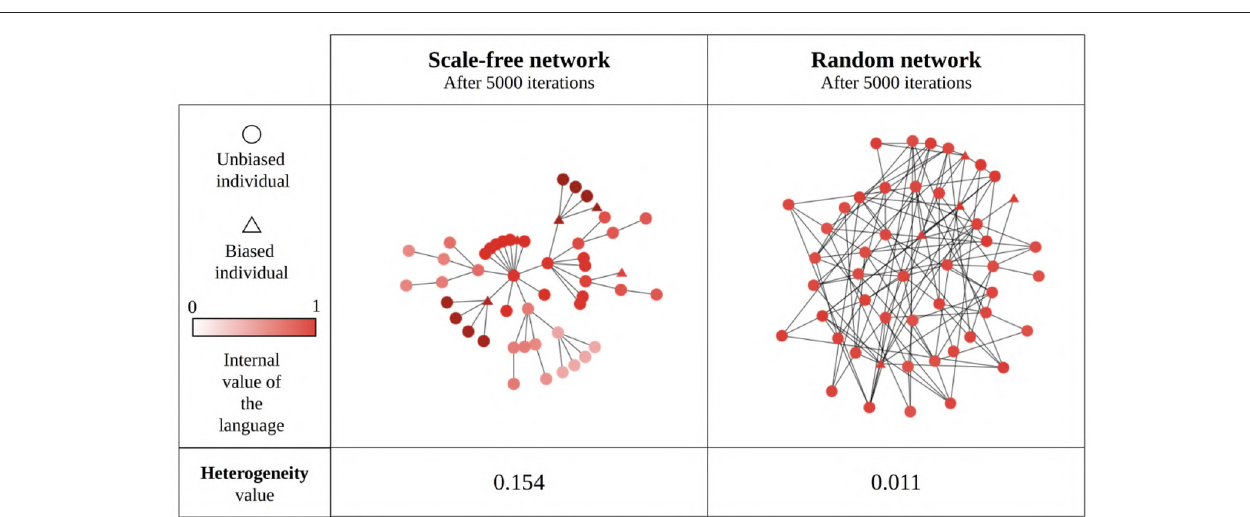
Frontiers in Psychology |